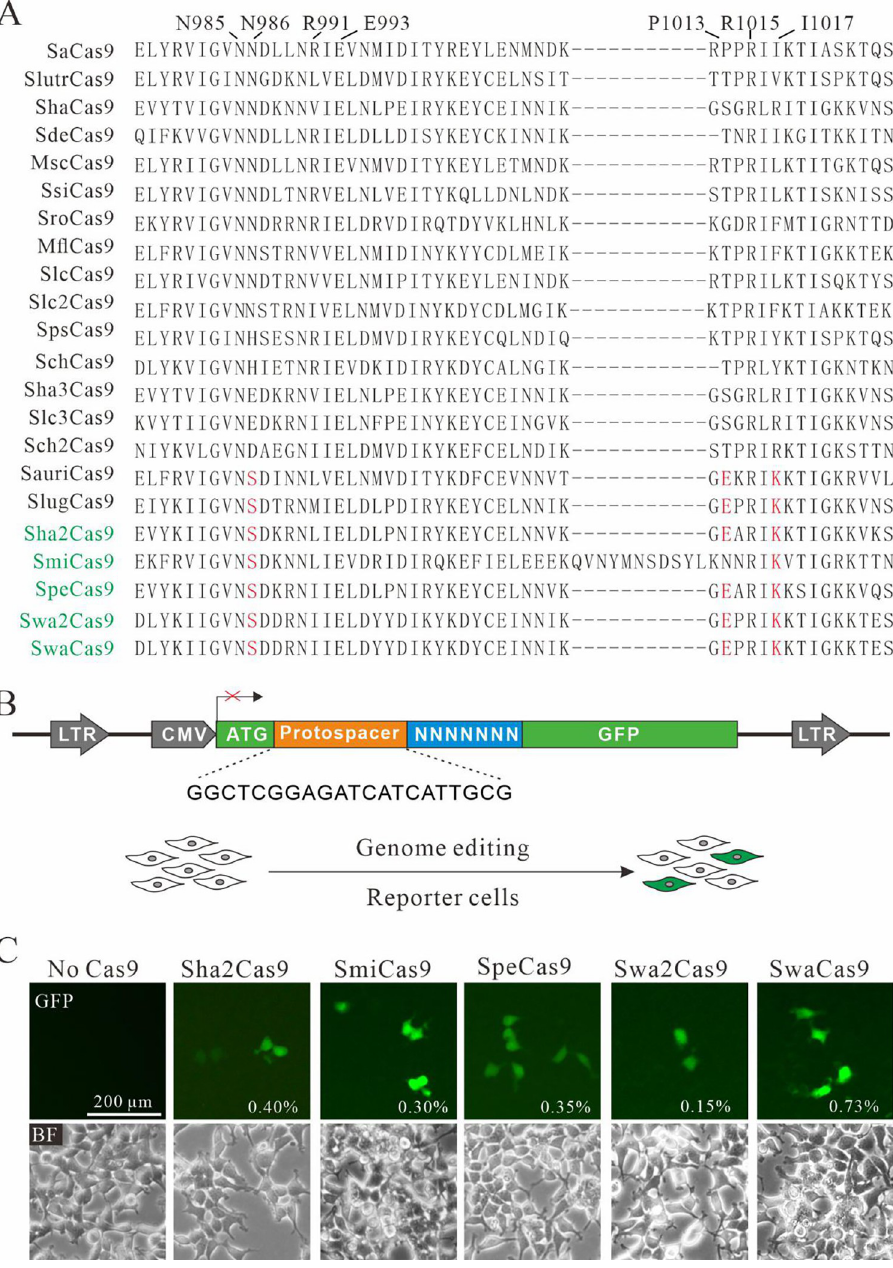
Fig 1. Analysis of five SaCas9 ortholog activities. ( A ) Amino acid sequences of the SaCas9 ortholog PI domain are aligned. The residues that are important for PAM recognition are indicated at the top; the conserved residues among newly identified SaCas9 orthologs are shown in red; the names of newly identified Cas9s are shown in green. ( B ) Design of the GFP activation reporter construct. A target sequence (protospacer) containing a 7-bp random sequence is inserted between ATG and the GFP-coding sequence. The library DNA is stably integrated into HEK293T cells by lentivirus. ( C ) Transfection of SaCas9 orthologs induced GFP expression. Percentage of GFP-positive cells was shown. The cells without transfection of Cas9 were used as a negative